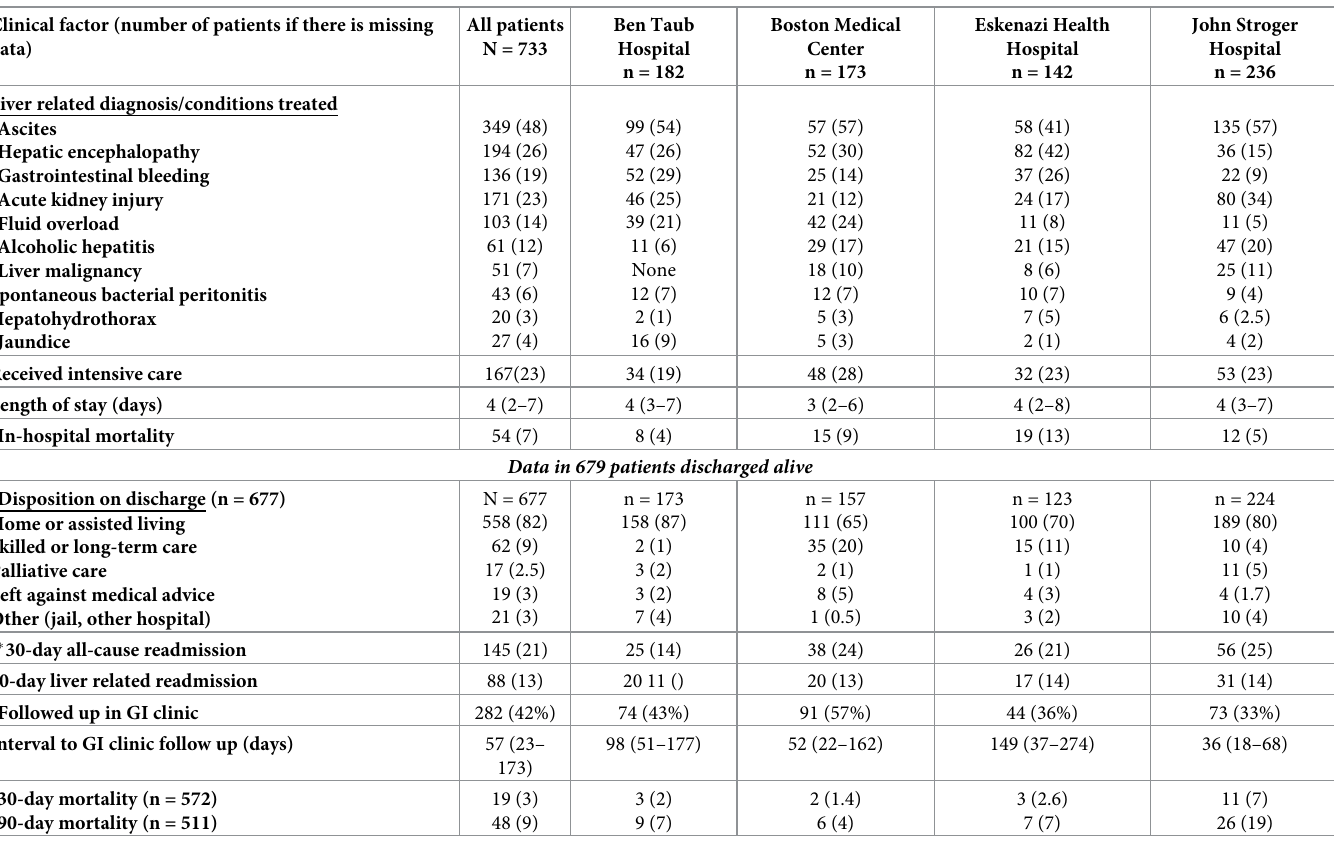
Table 3. The liver related diagnoses associated with the hospitalization in the study cohort, and outcomes of hospitalization, including mortality and early readmis- sion. Data are reported as number (percent) or median value (interquartile range). Clinical factor (number of patients if there is missing